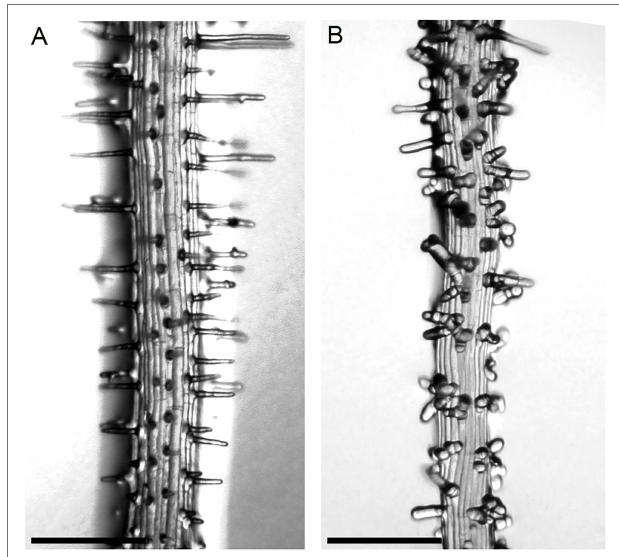
FIGURE 5 | Root hair phenotype of the Aascn1 mutant. (A) Wild type. (B) Aascn1 exhibits multiple bulges initiated from each epidermal cell and multiple growing axes initiated from each bulge. Scale bar: 250 μ